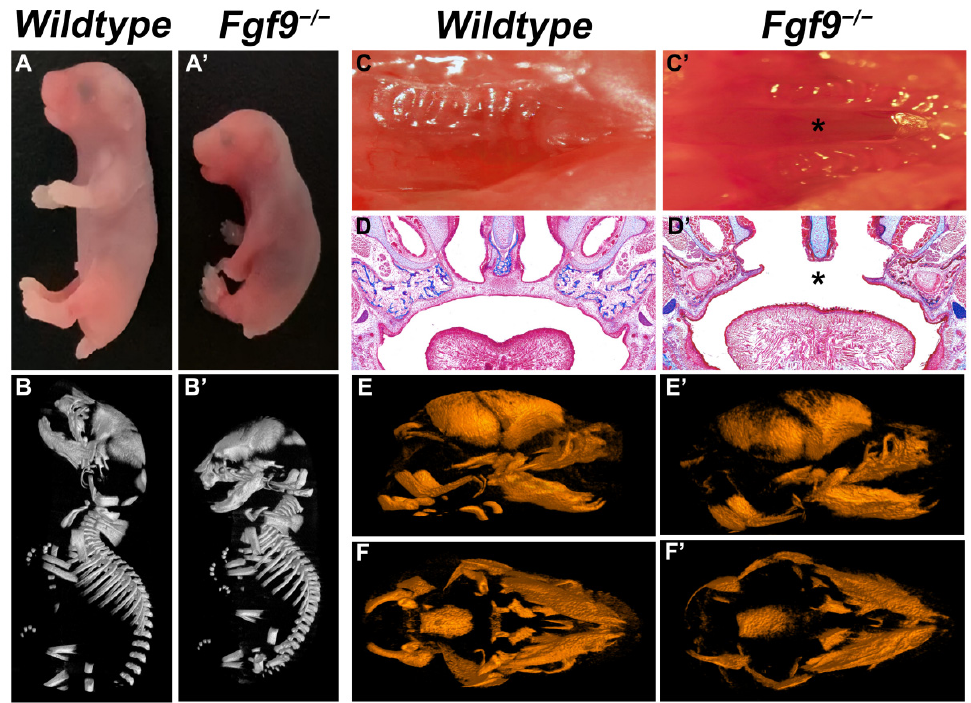
Figure 1. Craniofacial phenotypes of Wildtype and Fgf9 − / − embryos. ( A , B ) Comparison of the size of ( A ) Wildtype and ( A’ ) Fgf9 − / − mice at E18.5 by gross observation ( A , A’ ) and micro-CT scans ( B , B’ ). Inferior axial views of ( C ) Wildtype and ( C’ ) Fgf9 − / − E18.5 palates. MT staining of coronal sections in ( D ) Wildtype , and ( D’ ) Fgf9 − / − palates. Lateral views of ( E ) Wildtype and ( E’ ) Fgf9 − / − craniofacial skeletons provided by micro-CT scans. Inferior axial views of ( F ) Wildtype and ( F’ ) Fgf9 − / − craniofacial skeletons provided by micro-CT scans. Black star * indicates cleft secondary palate.